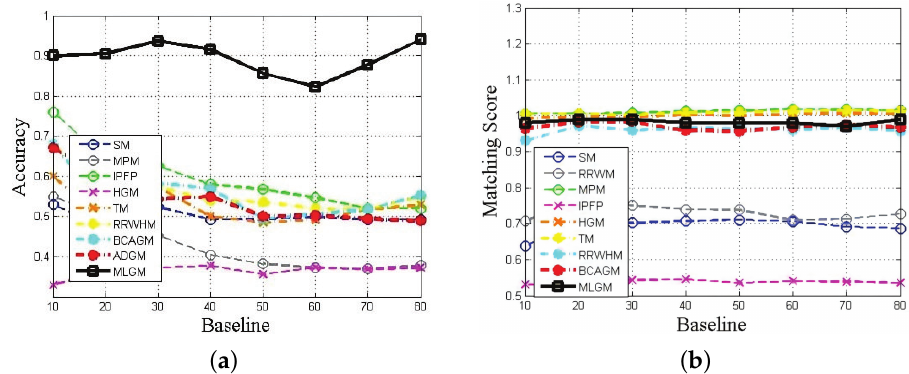
Figure 11. Trend chart of matching accuracy and score of the Face dataset. ( a ) Accuracy of the Face dataset. ( b ) Matching score of the Face dataset. Figure 12. Example results of experiments on the Duck dataset.